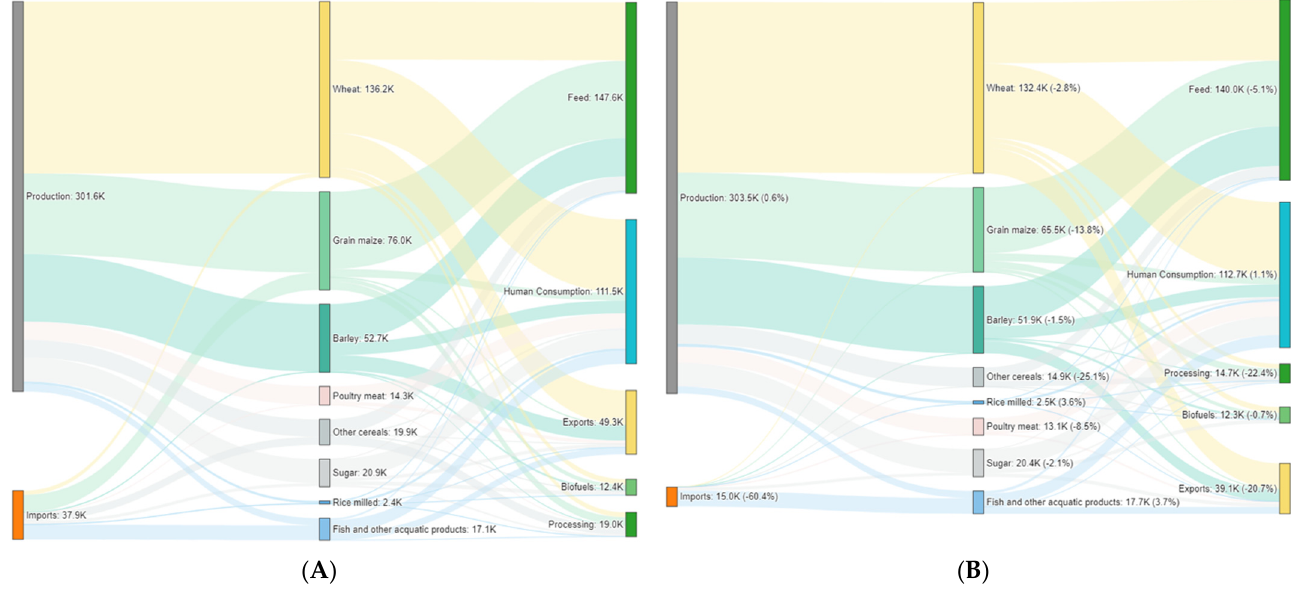
Figure 1. Elements of the market balance for cereals, sugar, and meat markets for the EU, in the baseline and a cease of import scenario, in different tones; ( A ) presents the baseline; ( B ) describes the cease of import scenario. The percentage change compared to the baseline is presented in brackets in ( B ), after the totals in K = 1000 tones.